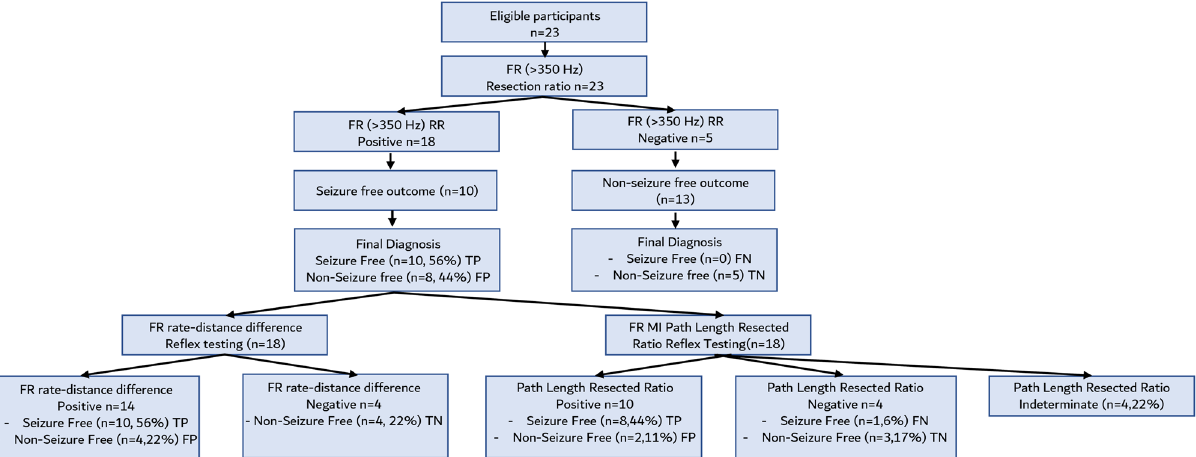
Figure 8. Flow chart of diagnostic accuracy of the fast ripple (FR) > 350 Hz resection ratio (RR) for diagnosing post-operative seizure freedom with reflex testing using either the FR rate-distance difference or the FR mutual information (MI) characteristic path length resected ratio. The thresholds for the tests were determined by the maximum of Youden’s J of the respective receiver operating characteristic curves (not shown). TP true positive, FP false positive, FN false negative, TN true negative.